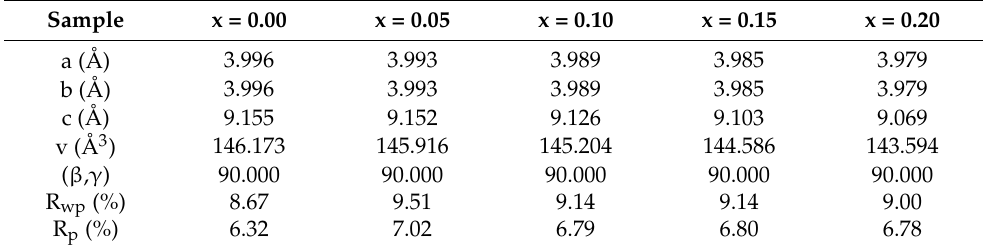
Table 1. Lattice constant of BiOBr X I 1 − X .